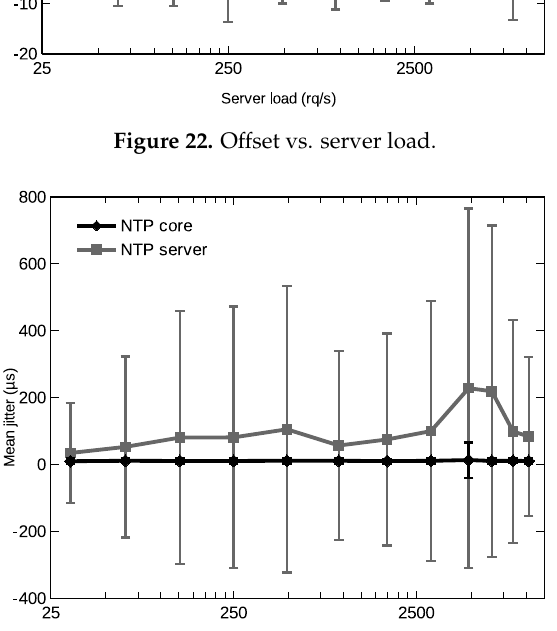
Figure 23. Jitter vs. server